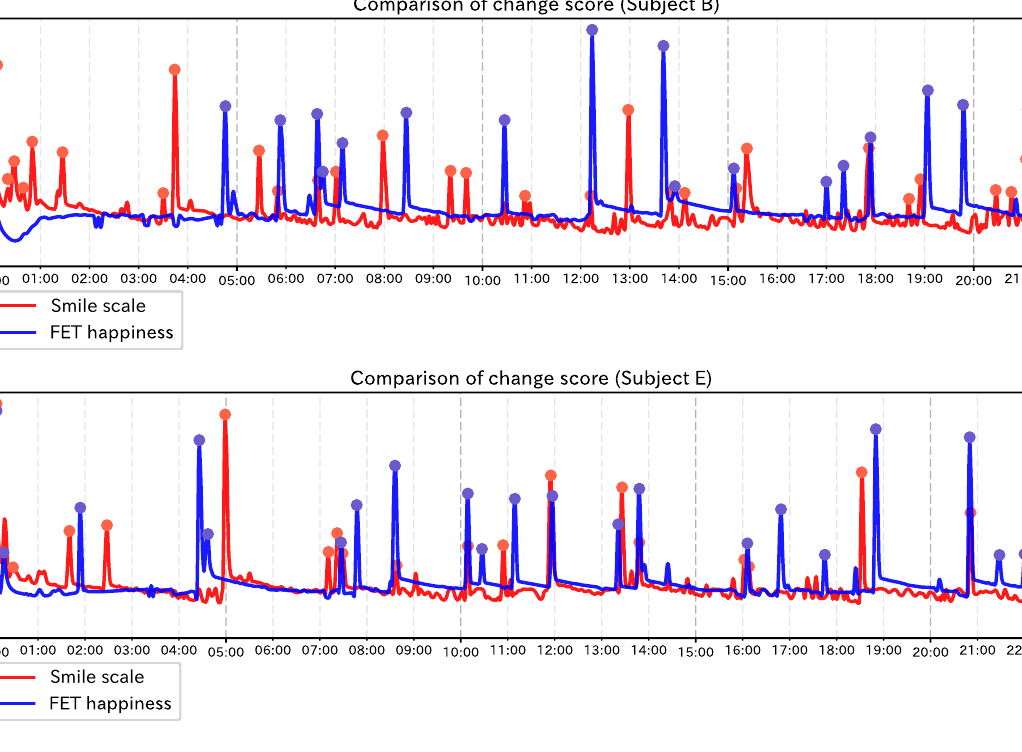
Figure 15. Comparison of change score between Smile scale and FET “happiness” value (Subject group